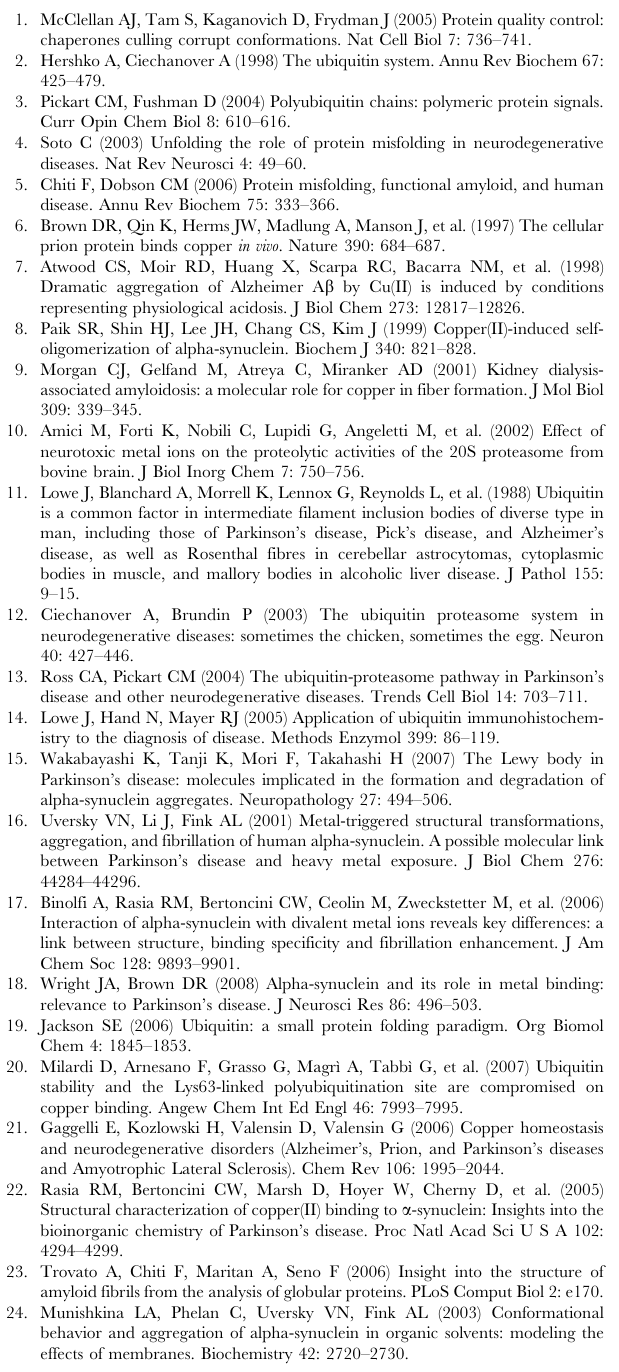
Figure S5 Reconstitution of Cu(II)-stabilized Ub oligomers in phospholipid bilayers. Phase-mode AFM images and cross- sectional profile, taken along the red line, of POPC liposomes (A) and POPC planar bilayers (B) in the absence of protein; topographic AFM images of annular (C) and pore-like structures (D) formed by Ub preincubated for two weeks at 37 u C with 3 mol equiv of Cu(II) in aqueous solution and then dissolved in POPC liposomes and in POPC planar bilayers. The corresponding cross- sectional profiles and 3D views are shown at the